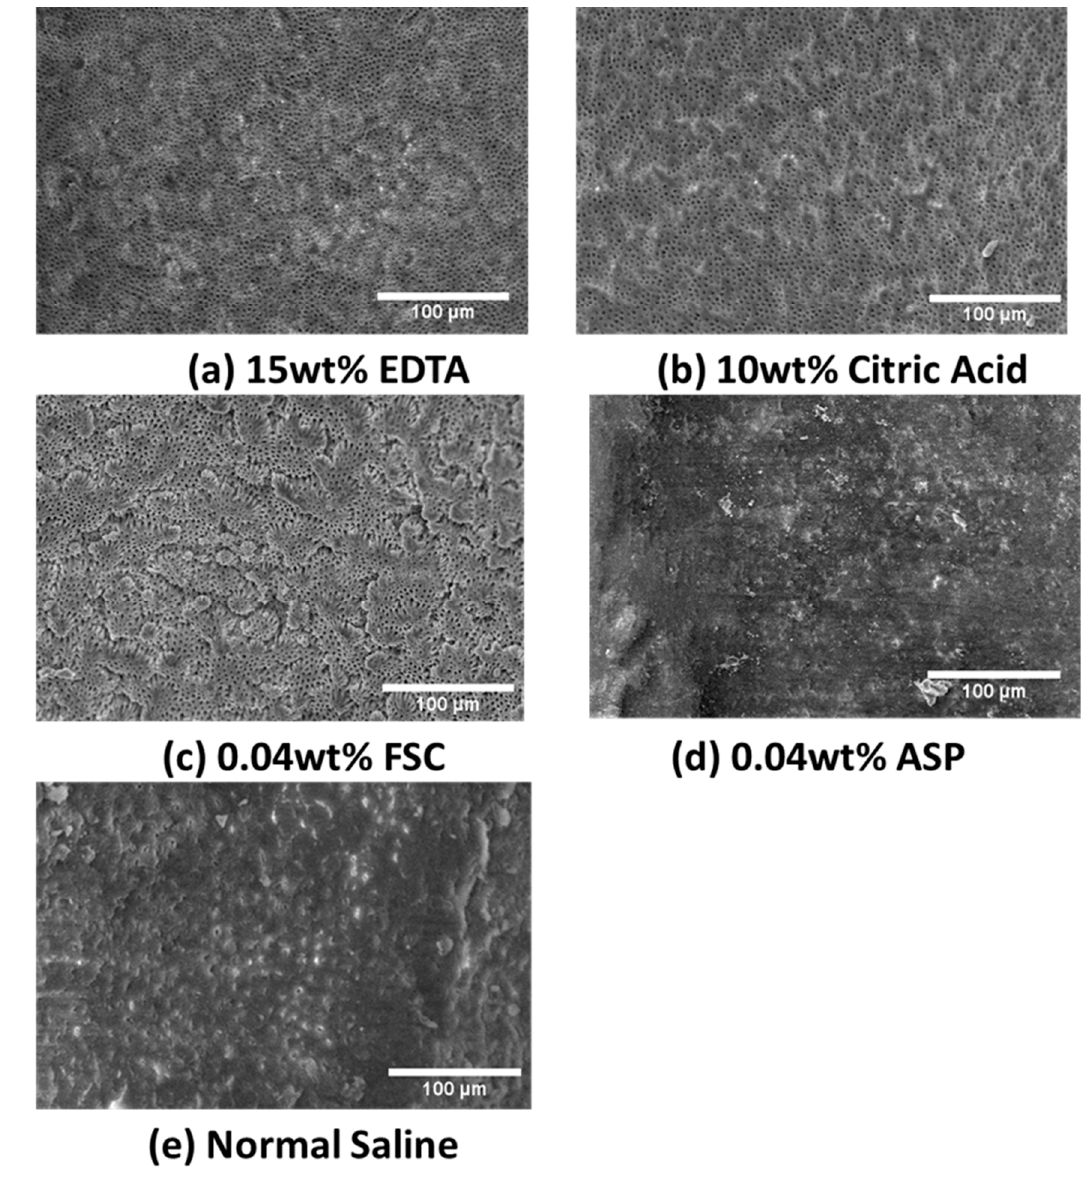
Figure 3. The representative scanning electron microscopy (SEM) photographs (350 × ) of the prepared surface treated by various irrigation solutions: ( a ) 15 wt% ethylenediaminetetraacetic acid (EDTA); ( b ) 10 wt% citric acid; ( c ) 0.04 wt% fungal chitosan (FCS); ( d ) 0.04 wt% alkali-soluble polysaccharide (ASP); ( e ) normal saline.